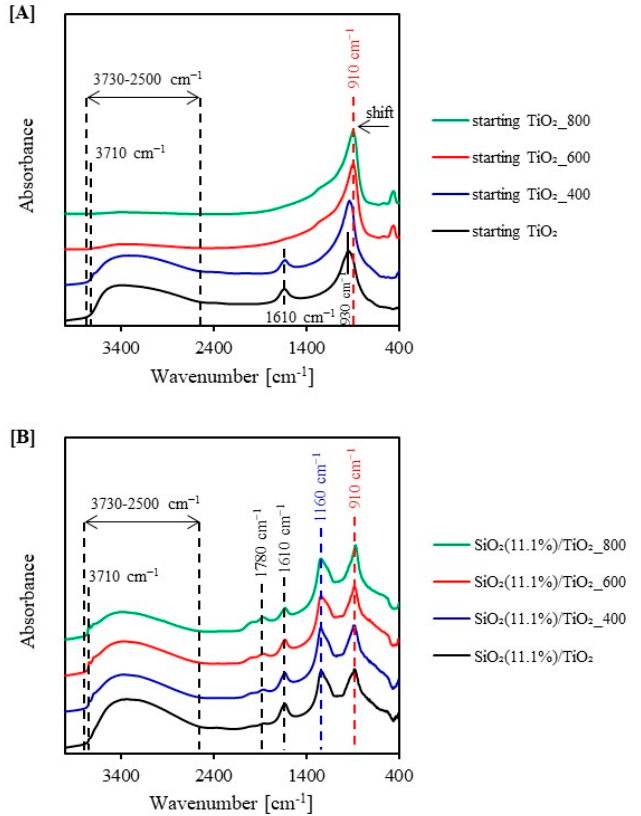
Figure 3. FT-IR/DR spectra of starting TiO 2 and reference materials ( A ) and fumed silica-modified TiO 2 prior and after heat treatment ( B ).